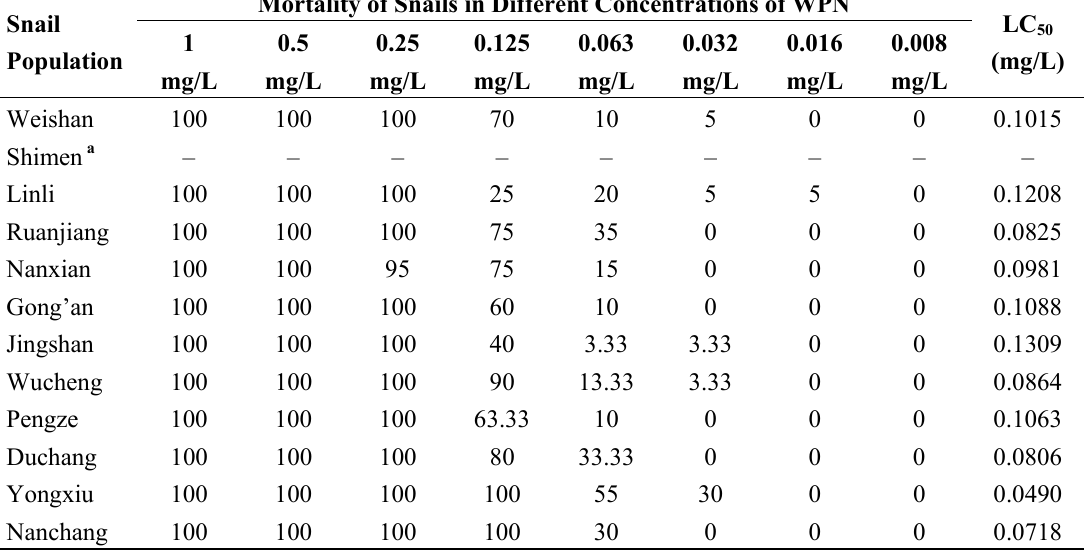
Table 3. Comparison of mortality rates and LC sampled from different regions of China following immersion in various concentrations of WPN for 48